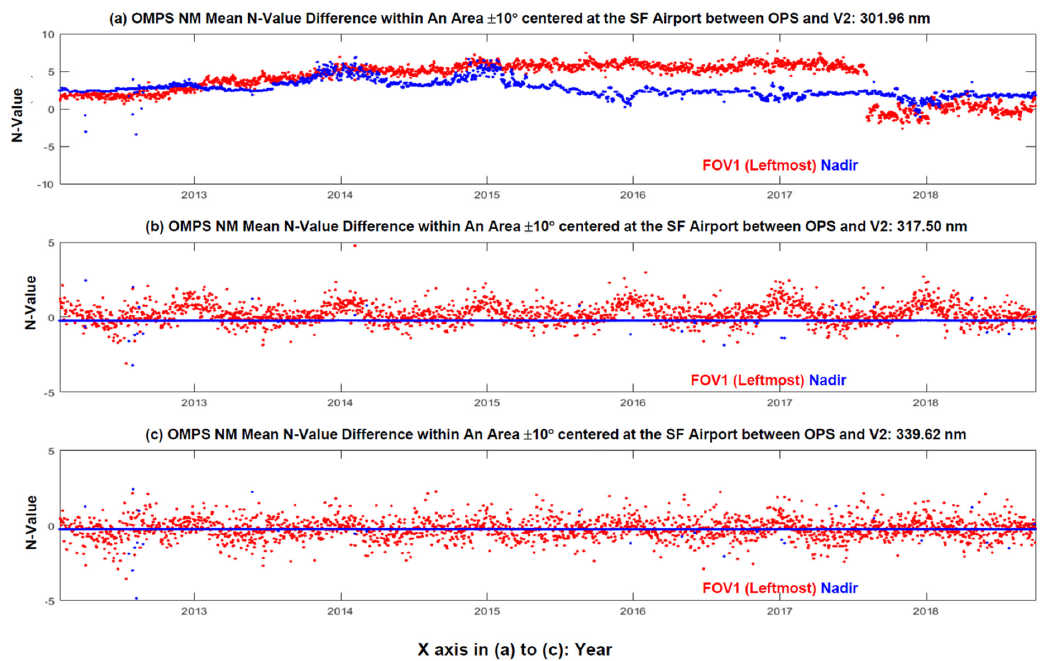
Figure 13. Same as Figure 12 except for averaged N-values at three wavelengths (301.96 nm, 317.497 nm, and 339.622 nm); ( a ) 301.96 nm, ( b ) 317.497 nm, ( c ) 339.622 nm. 317.497 nm, and 339.622 nm); ( a ) 301.96 nm, ( b ) 317.497 nm, ( c ) 339.622